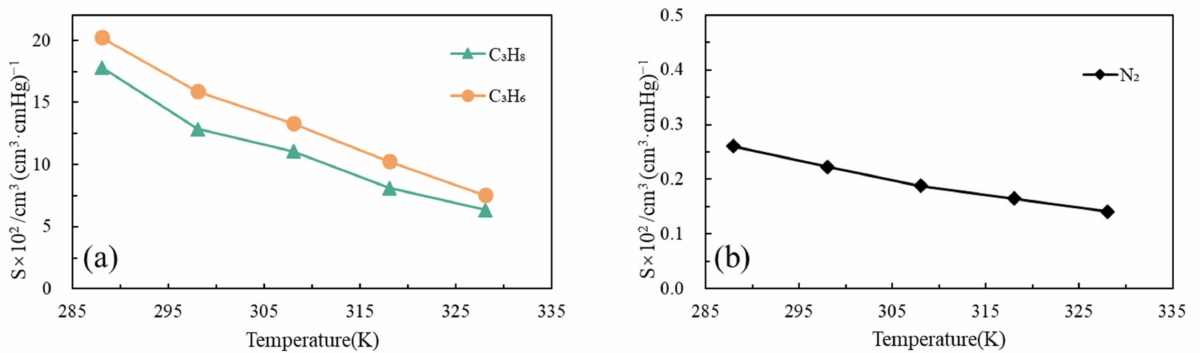
Figure 9. Solubility coefficients of ( a ) C 3 and ( b ) N 2 in the PDMS membranes at different temperatures.